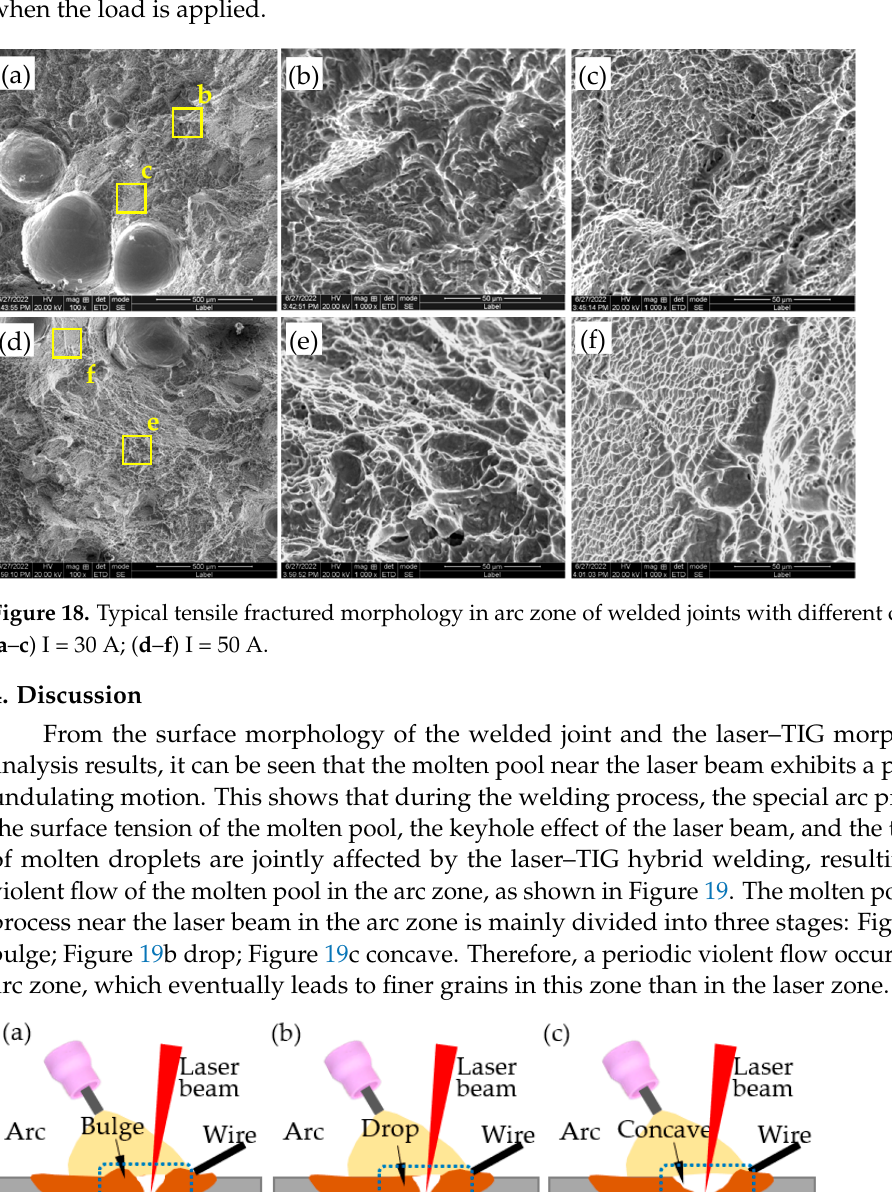
Figure 17. Tensile test results of welded joints with different currents: ( a ) tensile strength; ( b ) frac- ture location.